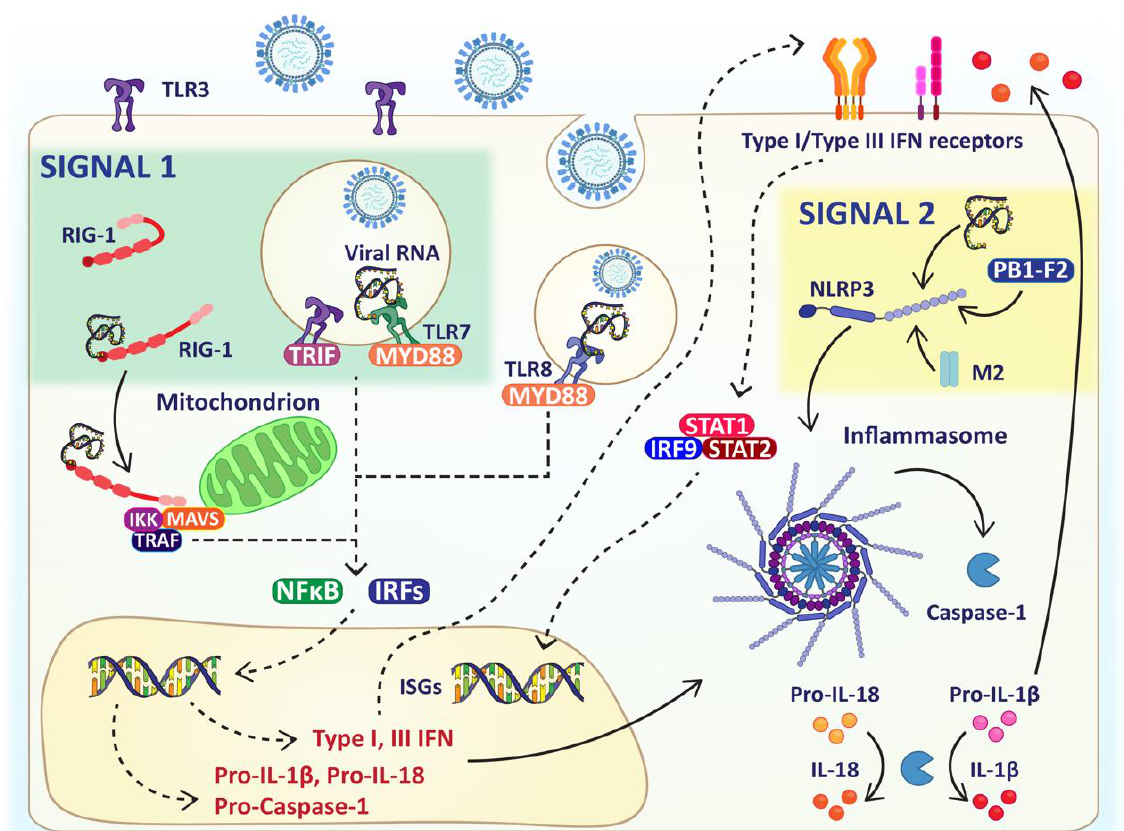
Figure 2. Localisation of PRRs responsible for influenza viral recognition. Schematic of PRRs responsible for viral recognition. The inflammasome requires two signals for activation and are shaded green and yellow, respectively. Image made using BioRender.